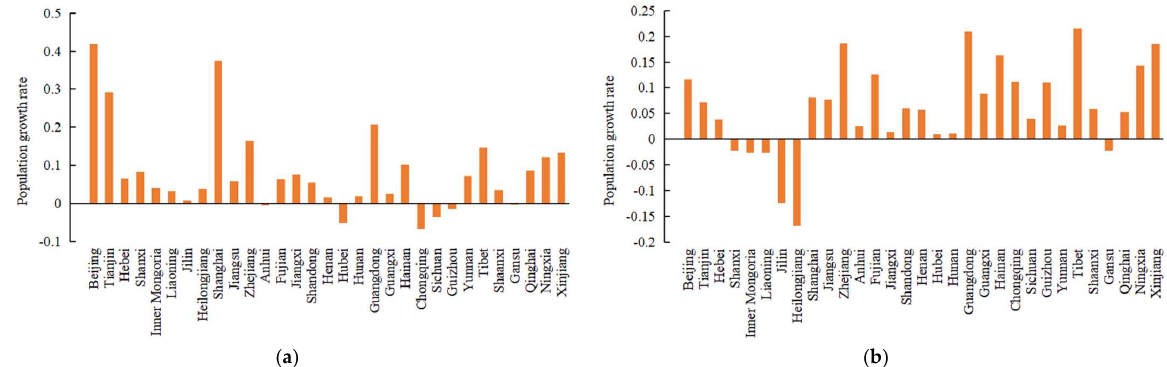
Figure 7. The population growth rates of each province for ( a ) 2000−2010 and ( b ) 2010−2020.